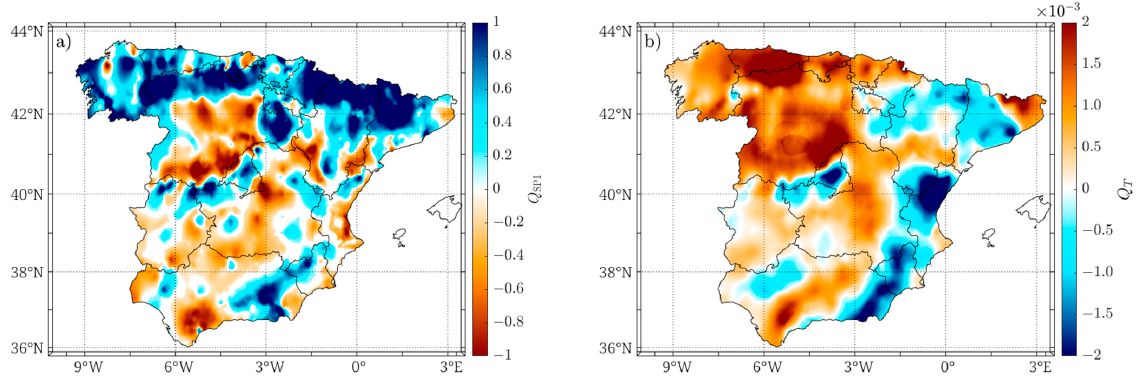
Figure 5. GPP ( a ) and NPP ( b ) normalized trends ( Q GPP and Q NPP ) at a significance level of p- value < 0.1 across the period 2004–2018. The error associated with Q GPP ( c ) and Q NPP ( d ) is also included. White color refers to pixels with a slope that is very small or pixels with a nonsignificant Mann– Kendall test value (0 value). For NPP, white color also refers to non-forest pixels.